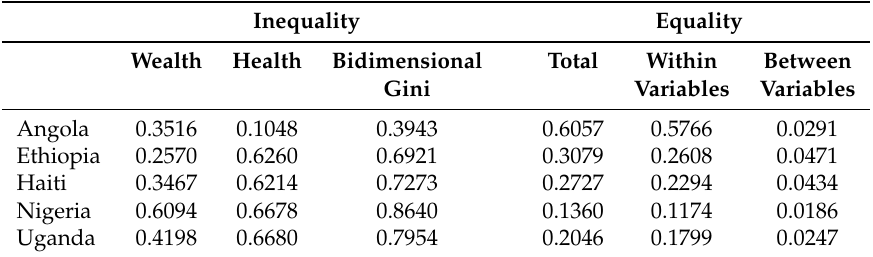
Table 2. Bivariate Gini index (Equation (15)) and marginal Gini indices (27) and Decomposition of the equality (Equation (16)) for the Sarmanov–Lee distribution with classical beta marginals. Inequality Equality Wealth Health Bidimensional Total Within Between Gini Variables Variables